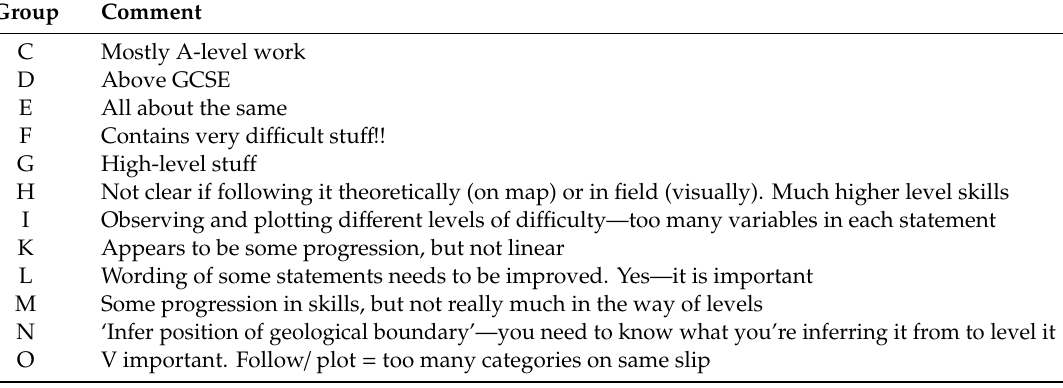
Table A7. Map geological boundaries properly.